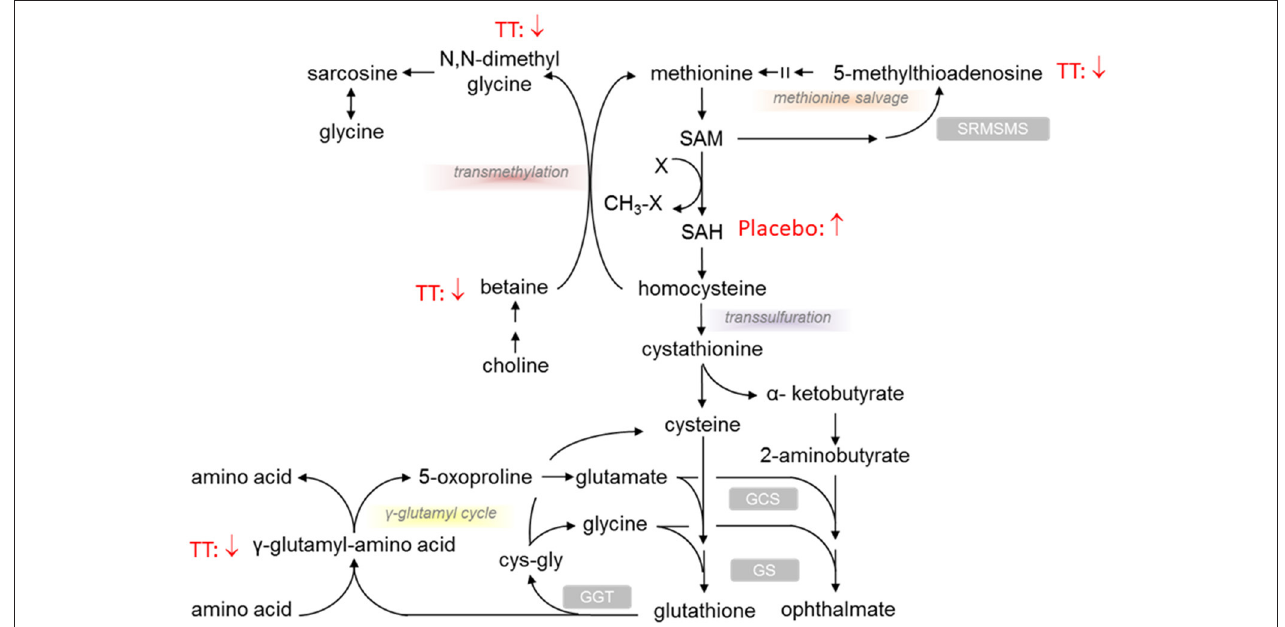
FIGURE 3 | Effect of tocotrienols supplementation on redox environment biochemical pathways. Proposed actions of tocotrienols on compounds associated with redox pathways based on serum analysis from subjects. Tocotrienols tended to result in lower levels of compounds where the downward arrows are shown.